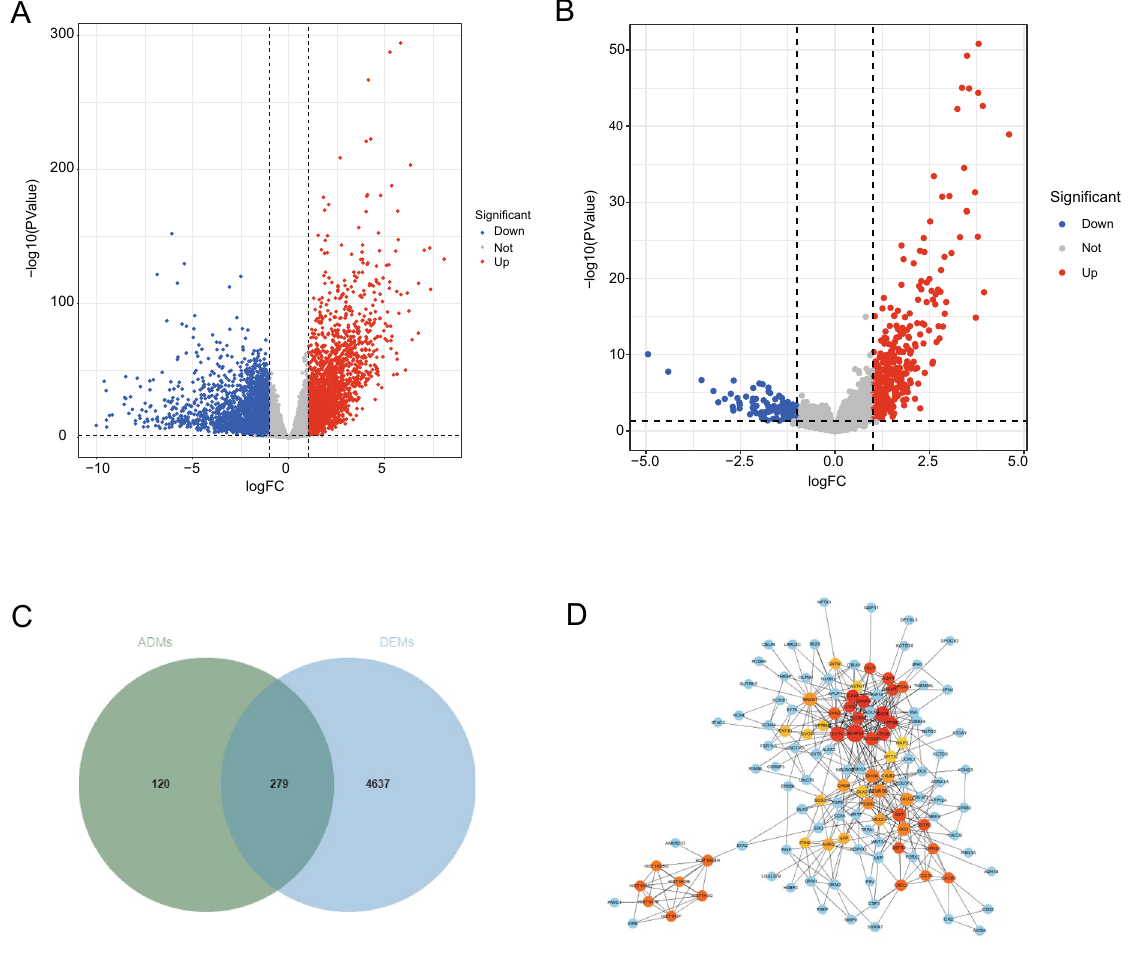
Figure 1. Differentially expressed genes in the TCGA database. ( A ) The DEGs between CRC and normal samples. ( B ) The DEGs between young and old groups. ( C ) The Venn diagram describes 279 common differentially expressed genes. ( D ) PPI network of 279 common genes. (software: The STRING database, version number: 11.0, URL link: https:// versi on- 11-0. string- db.